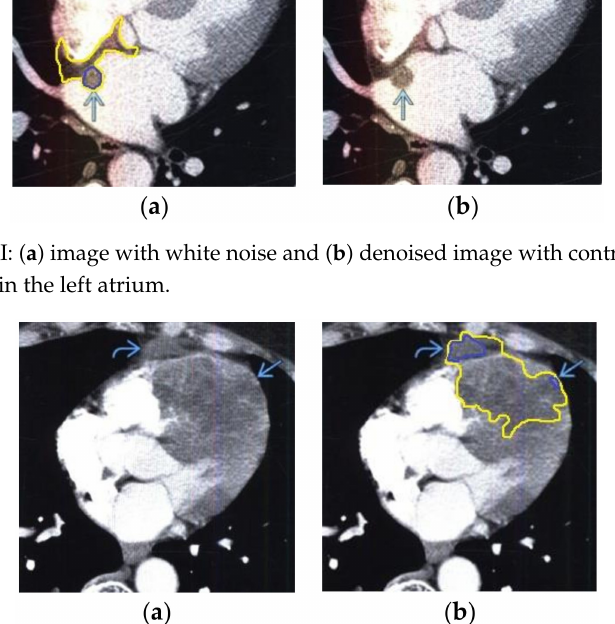
Figure 6. Heart MRI: ( a ) image with white noise and ( b ) denoised image with contrast enhancement of volumetric heterogeneous formation in the form of